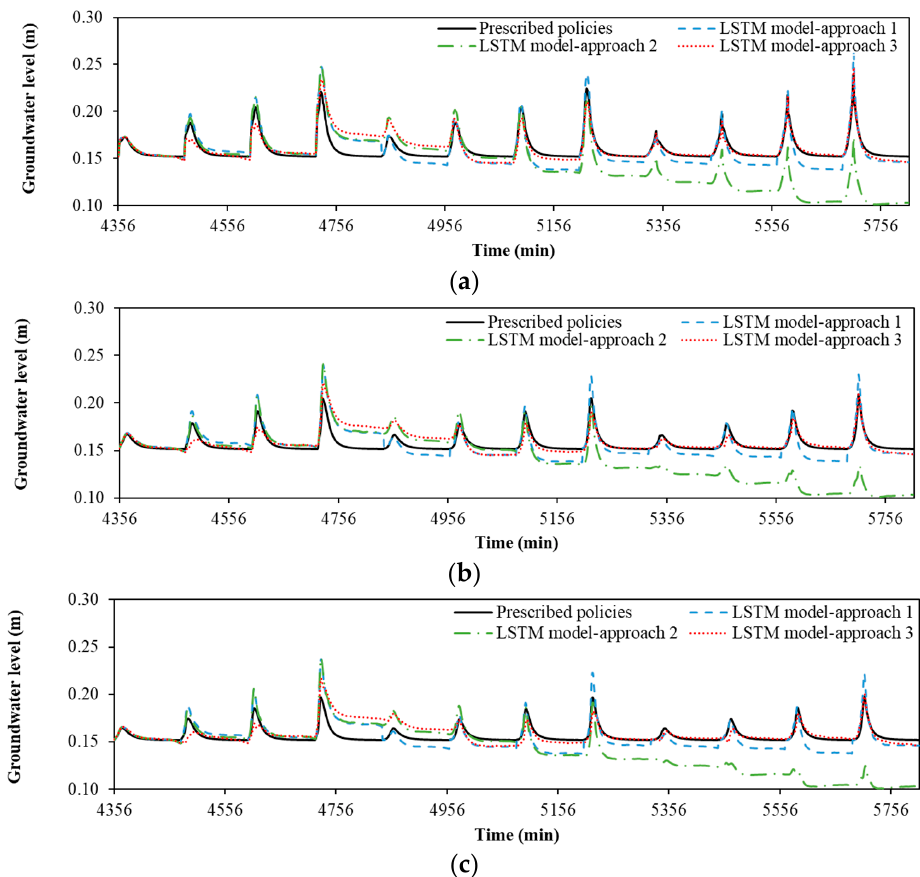
Figure 12. Comparison of the groundwater level using the three approaches of applying the proposed LSTM model and the predefined pumping policies at ( a ) point P 1 , ( b ) point P 2 , and ( c ) point P 3.